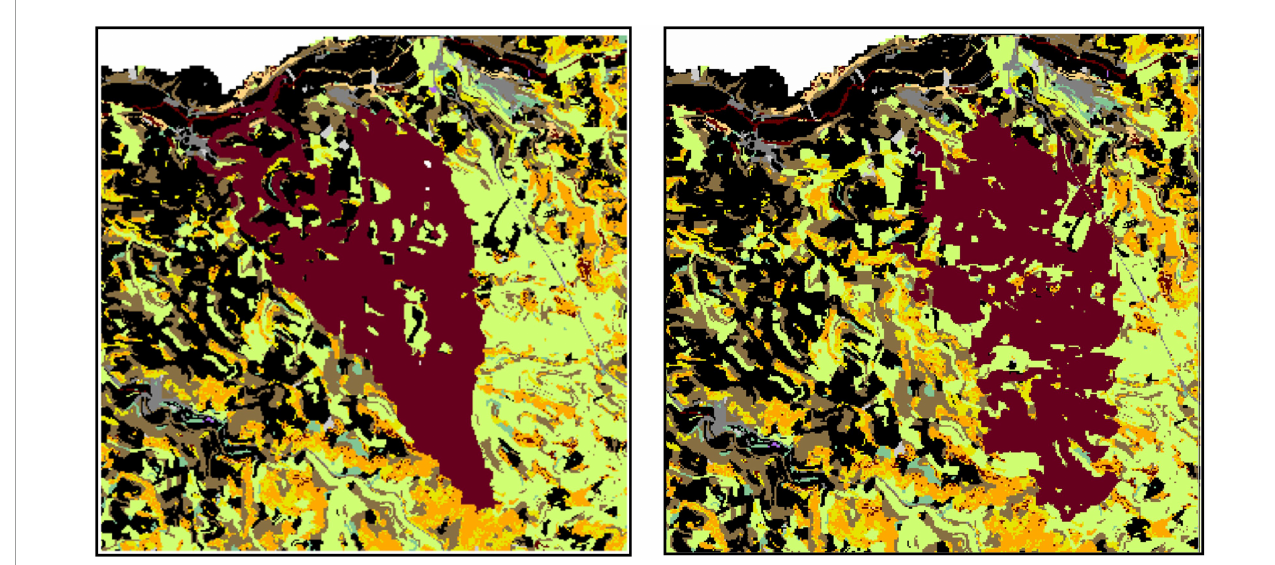
FIGURE4 Representation of a simulated fire. The propagation tree shows the fire contagion patterns or the paths followed by fire as it spreads across the landscape from a burning cell to its adjacent neighbors.